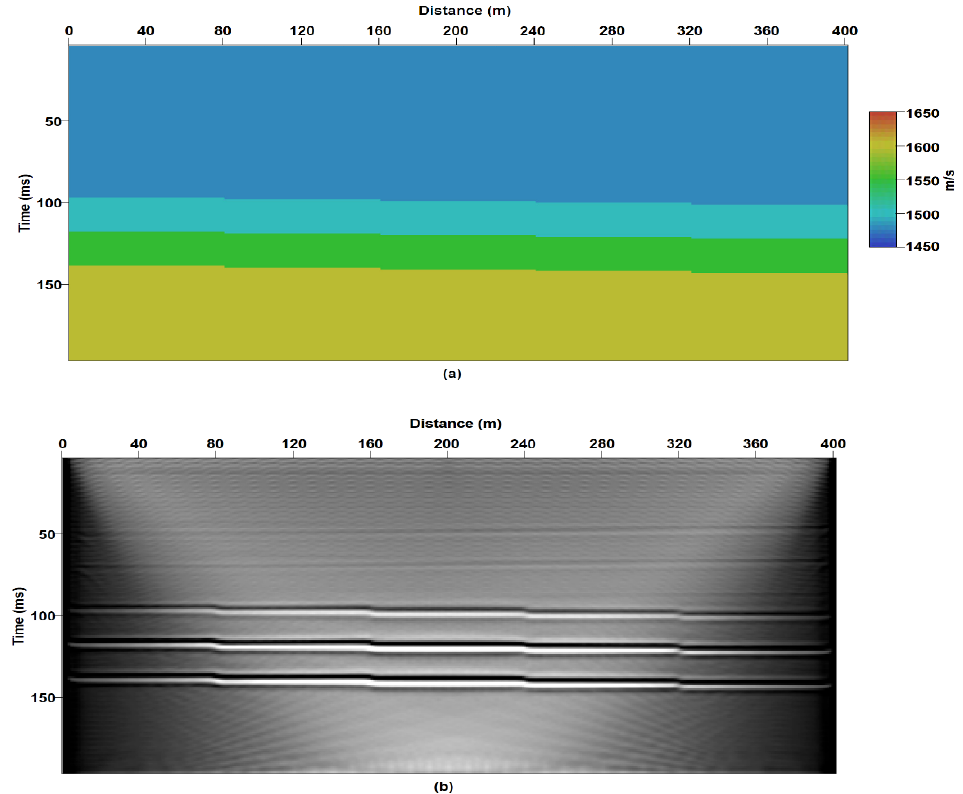
Figure 3. Numerical imaging results: ( a ) input velocity model of the flat layered subsurface; ( b ) RTM image of the flat model.